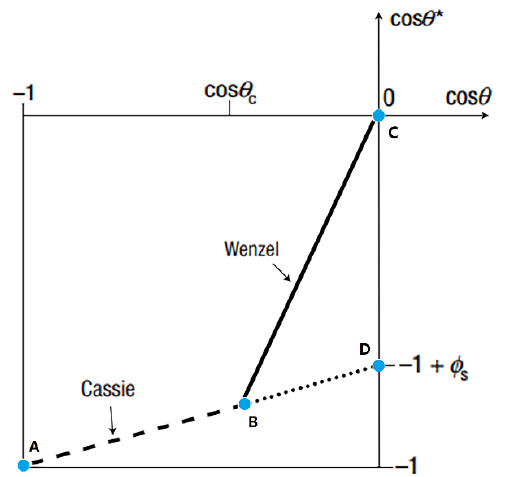
Figure 2. Two models of superhydrophobicity. The solid line and dashed line represent Wenzel state and Cassie–Baxter state, respectively. The dotted line represents the metastable situation where the C–B state can also be observed for θ < θ c . The coordinates of A, B, C, and D are (cos 180 ◦ ,cos 180 ◦ ), (cos θ c ,cos θ ∗ ), (cos 90 ◦ ,cos 90 ◦ ), and (cos 90 ◦ ,cos θ ∗ ), respectively. Reprinted with permission from Ref. [9]. Copyright@2003, Nature Publishing